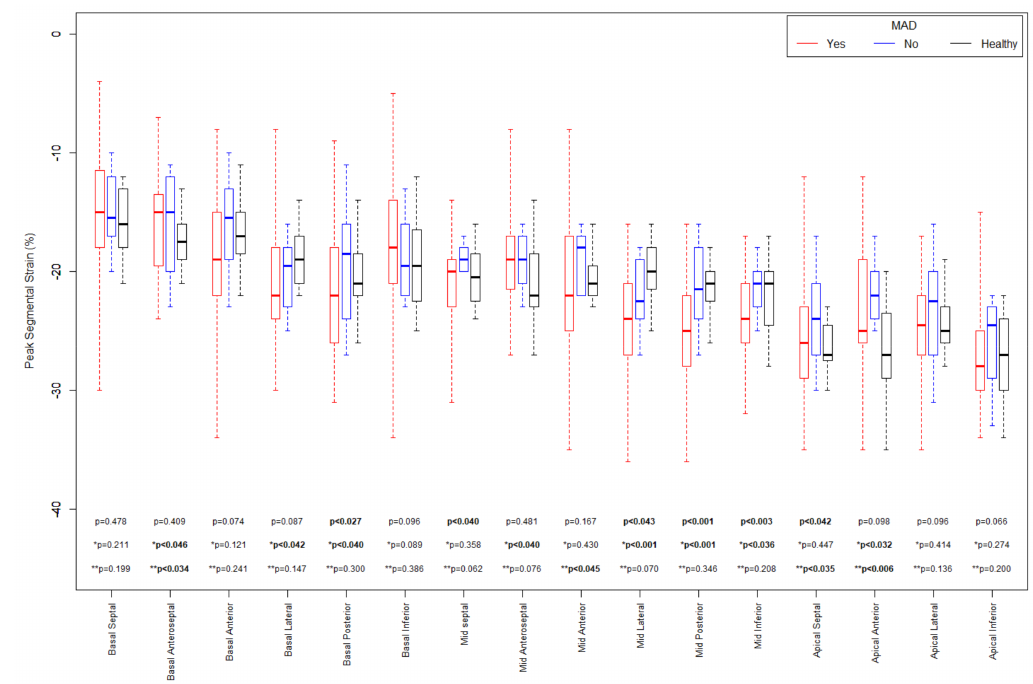
Figure 5. Peak Segmental Strain comparisons between MAD+, MAD − and Healthy groups in sixteen segments.